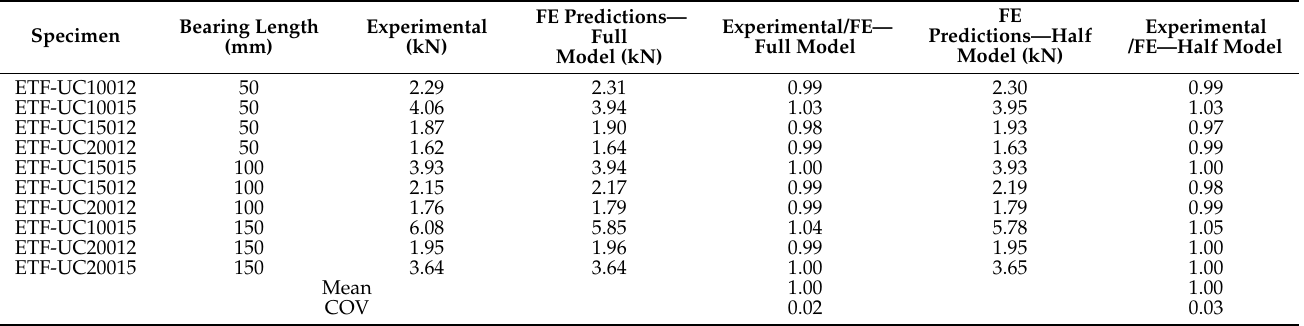
Table 3. Comparison of web crippling test strengths with FE results for unlipped channel sections under the ETF loading condition [21].